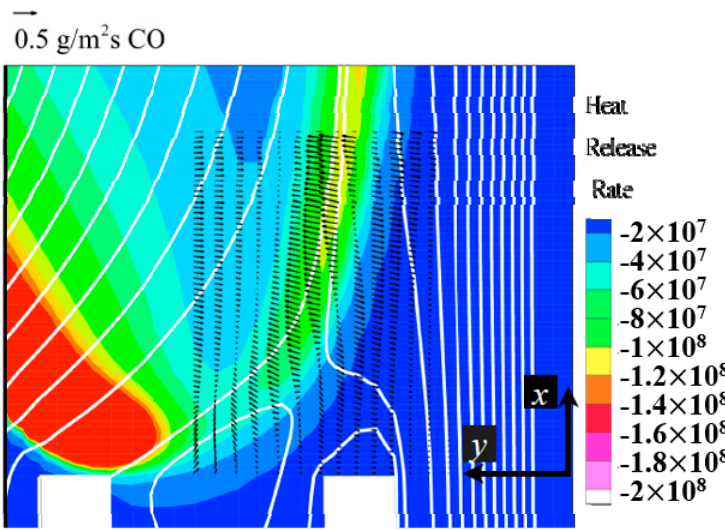
Figure 10. The CO diffusion vector distribution in the post-flame region between the outer and the center flame, in contrast to the streamline (line) pattern and color-coded heat release rate. The burning conditions were for the center flame at ϕ = 0.5 and outer flame at ϕ = 0.88. The average jet exit speed was equal to 1 m/s for both center and outer flames.